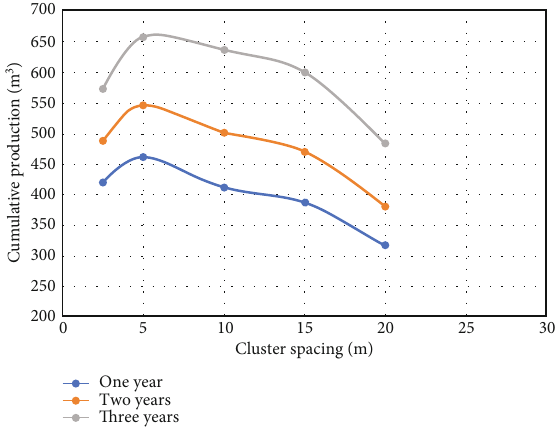
Figure 13: Cumulative production under di ff erent cluster spacings at 400 m well spacing.